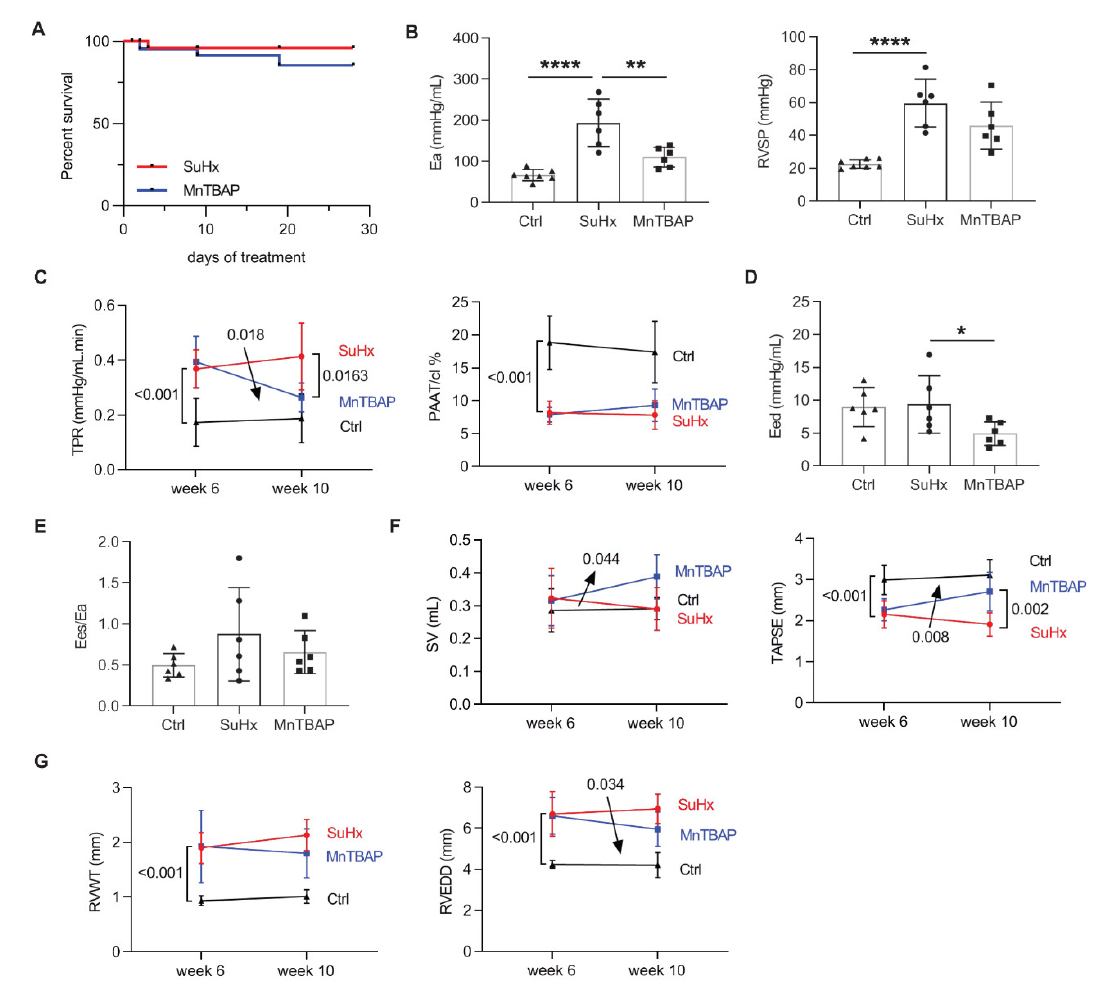
Figure 4. MnTBAP reduces right ventricular (RV) afterload and improves cardiac function in SuHx- induced PAH in rats. ( A ) MnTBAP treatment did not affect survival in PAH rats. ( B ) Pressure–volume loop analysis shows that MnTBAP treatment reduced RV afterload (Ea) at week 10, with remained RVSP. ( C ) Echocardiography analysis shows that MnTBAP delayed the progression of TPR from week 6 to week 10, and reduced TPR at week 10, while PAAT/cl% was not affected. ( D , E ) Pressure– volume loop analysis shows that MnTBAP reduced RV stiffness (Eed) at week 10, with remained RV- arterial coupling (Ees/Ea). ( F , G ) MnTBAP treatment delayed progression towards RV failure as shown by echocardiography at week 6 and week 10, with decreased RVEDD, and improved SV and TAPSE. Arrows represent significant interaction of the two-way ANOVA. Data presented as mean ± SD. * p < 0.05, ** p < 0.01, **** p < 0.0001 versus SuHx. Ea = arterial elastance, RVSP = right ventricular